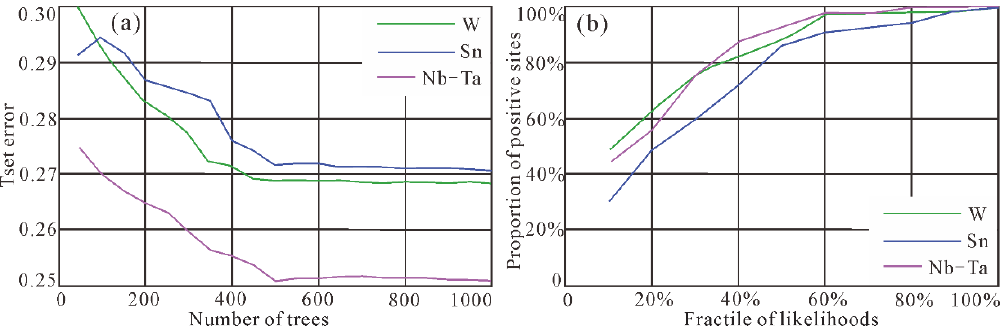
Figure 6. ( a ) Test error curves and ( b ) capture – efficiency curves of the RF